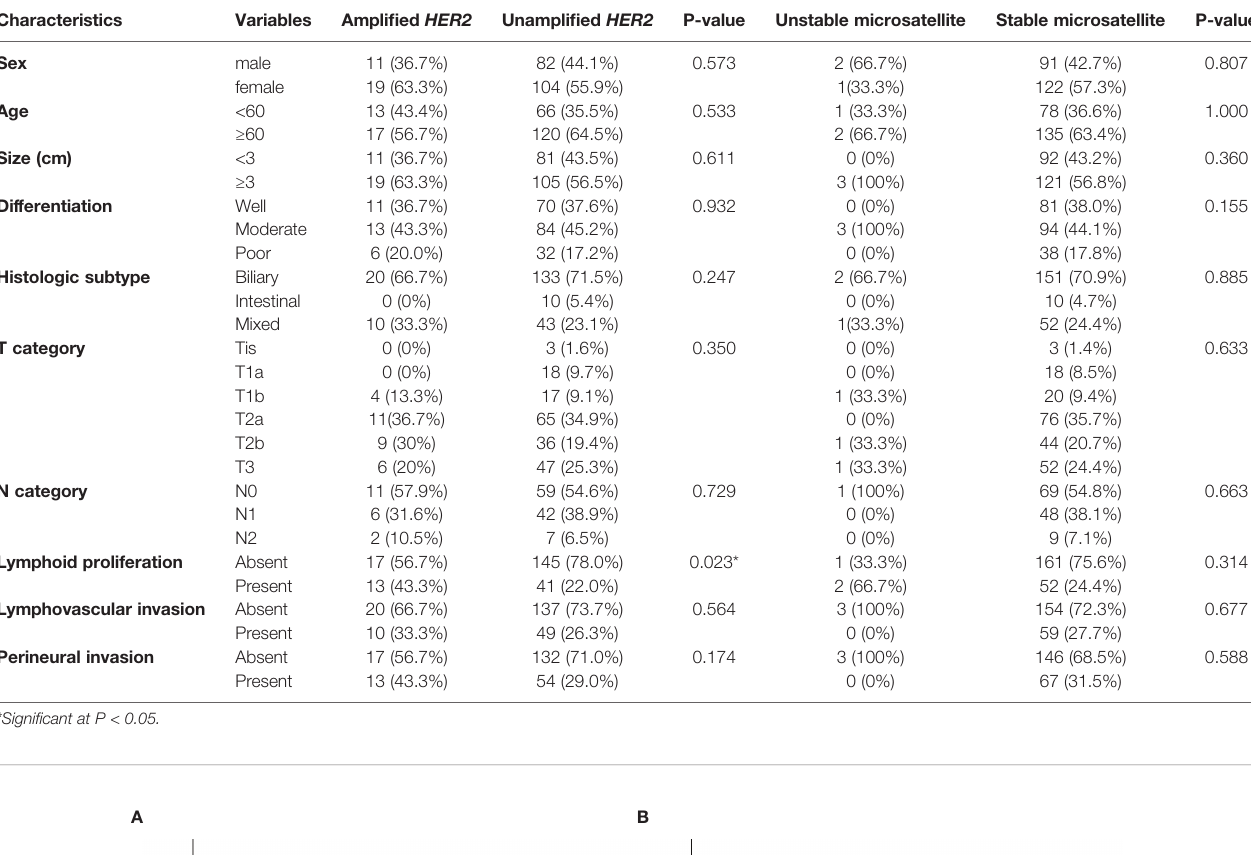
TABLE 3 | HER2 ampli fi cation and microsatellite status in association with clinicopathologic characteristics in gallbladder cancer. Characteristics